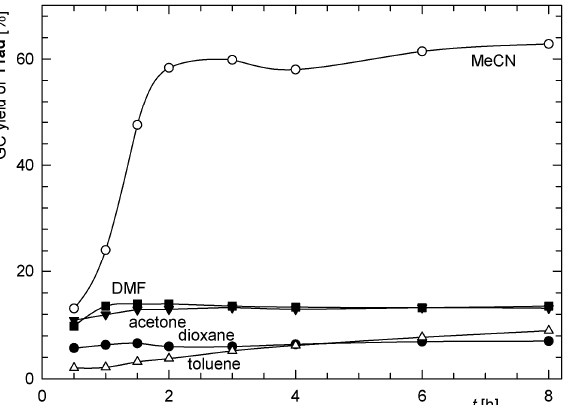
Figure 2. Kinetic profiles for the model coupling reaction performed in organic solvents with added triethylamine (5 equiv. NEt 3 , 0.5 mol.% catalyst 5 , 5 mol.% CuI) at 50 °C. Legend: MeCN ( ), DMF ( ), acetone ( ), dioxane ( ), toluene ( ). The solid lines connecting the experimental points are a visual guide and do not represent any fit of the data.